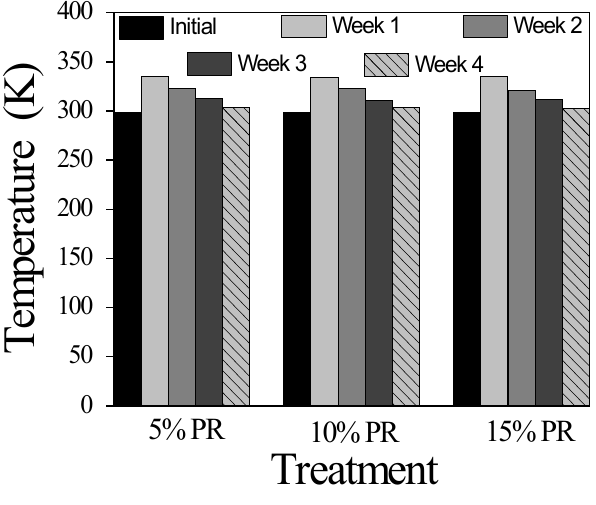
Fig. 3 Variation in compost temperature with different concentrations